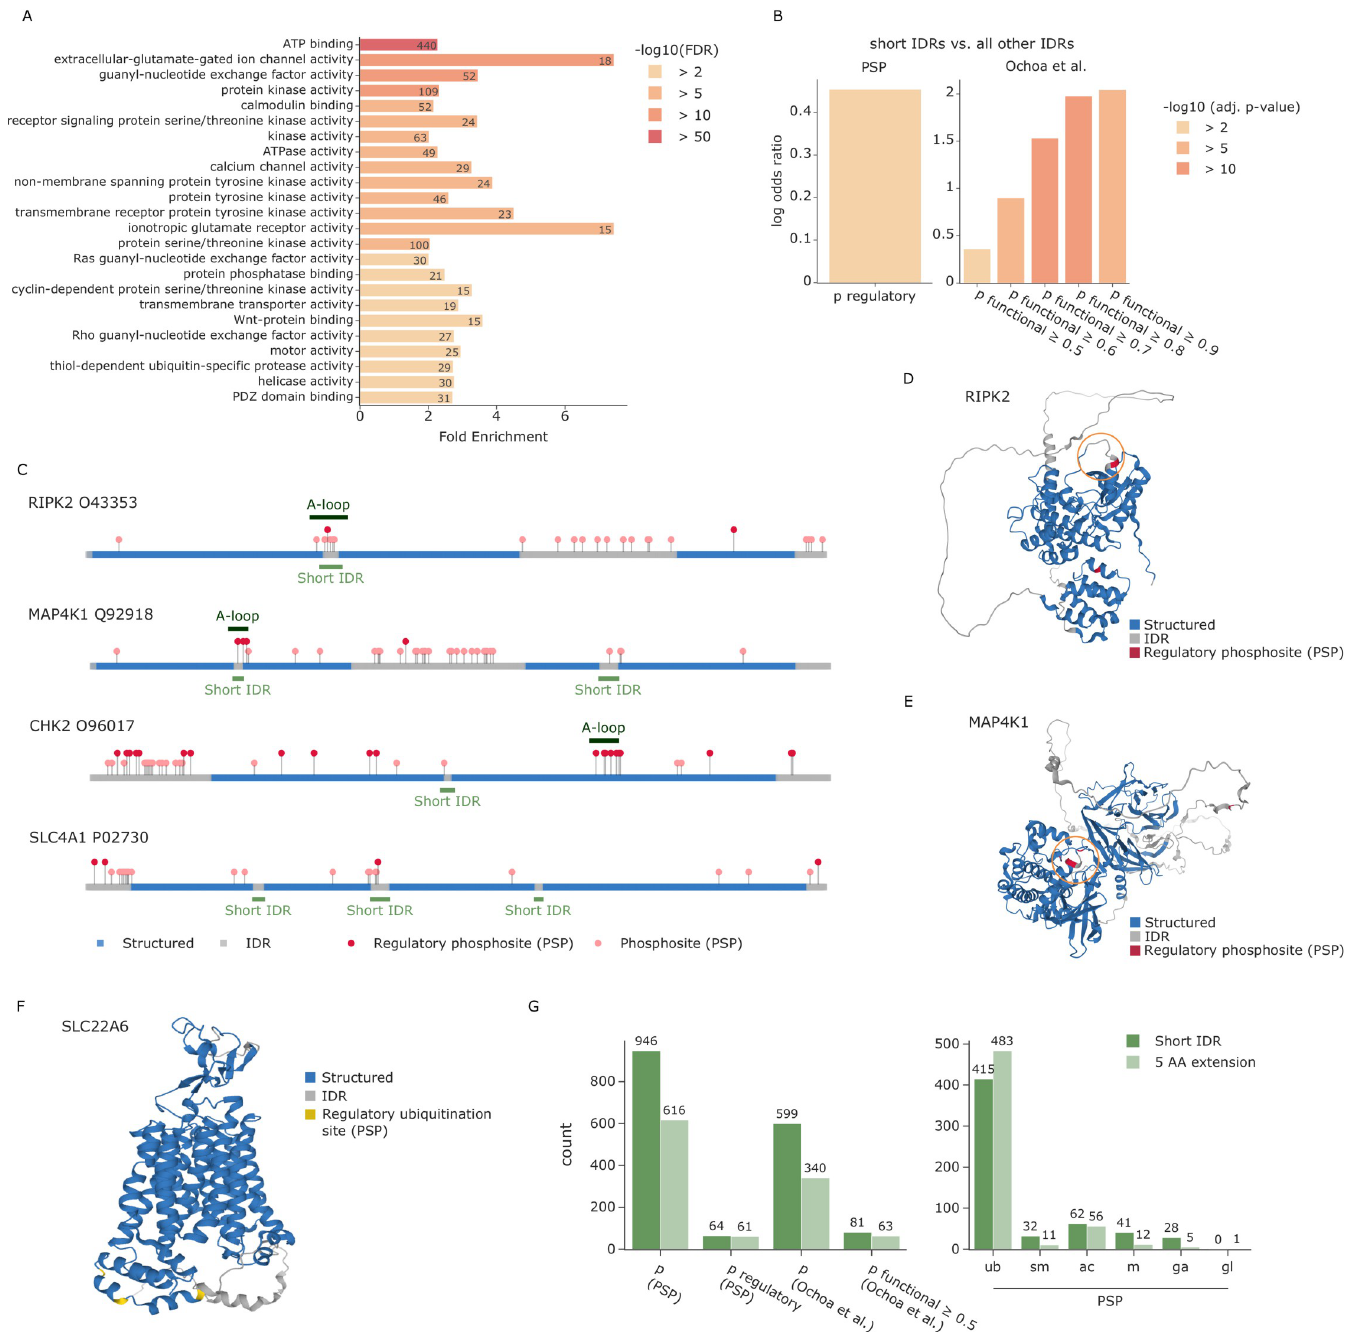
Fig 4. Regulatory PTMs accumulate in short IDRs. (A) Enrichment analysis of proteins with short IDRs. Source data are available at Github. (B) Enrichment of regulatory phosphosites from PSP in short IDRs compared to all other IDRs. Source data are available at Github and Github, respectively. (C) Sequence plot showing the N- to C-terminus of different proteins colored by whether the amino acid is part of a structured region (blue) or an IDR (gray). All phosphosites annotated in PSP are indicated by circles. Regulatory sites are colored in dark red and stand out higher than nonregulatory sites (salmon). Regions of short IDRs including a 5-amino acid extension are indicated in light green below the sequence. Annotated kinase activation loops (A-loops) from KinaseMD are indicated in dark green above the sequence. The predicted structures of RIPK2 (D) and MAP4K1 (E) are colored by structured regions (blue) and predicted IDRs (gray) as well as known regulatory phosphosites annotated in PSP (dark red). Specific regions of interest are highlighted by an orange circle. (F) The predicted structure of SLC22A6 is colored by structured regions (blue) and predicted IDRs (gray) as well as known regulatory ubiquitination sites annotated in PSP (yellow). (G) Overview of phosphorylations (left) and other PTMs (right) that lie within short disordered regions or their flanking 5 AAs. Source data are available at Github. AA, amino acid; IDR, intrinsically disordered region; MAP4K1, mitogen-activated protein kinase kinase kinase kinase 1; PSP, PhosphoSitePlus; PTM, posttranslational modification; RIPK2, receptor-interacting serine/ threonine-protein kinase